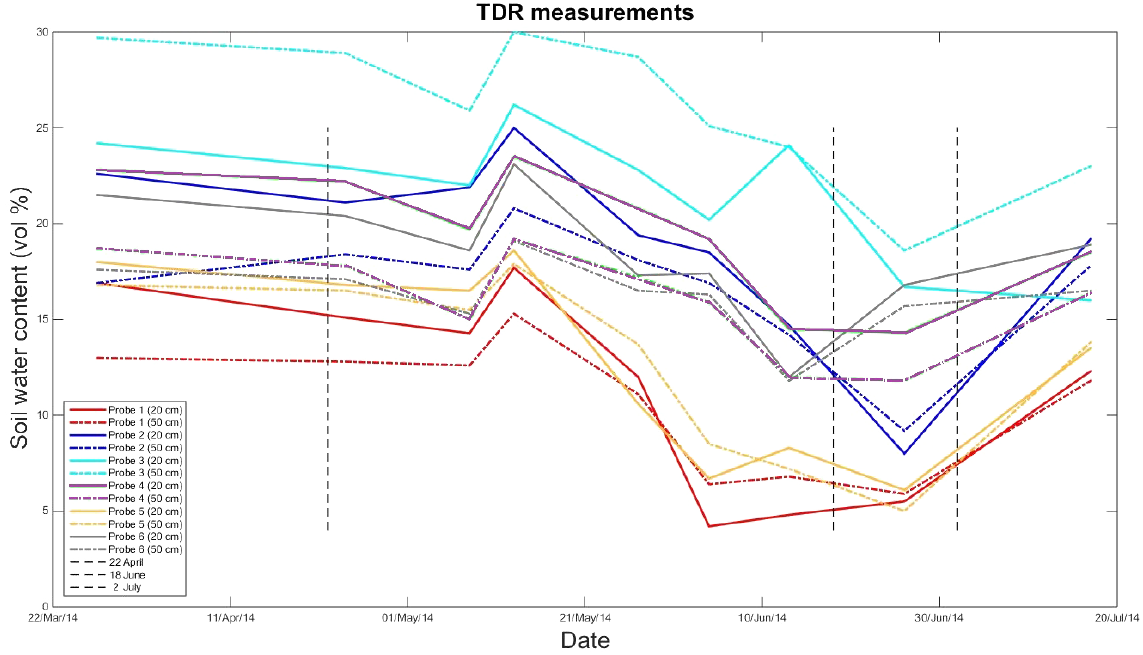
Figure D2. The soil water content measured at the six TDR probes during the growing season. Solid lines represent measurements at 0.2m depth and semi-dashed lines represent 0.5m depth. Black dashed lines indicate days of UAV data collection: 22 April, 18 June and 2